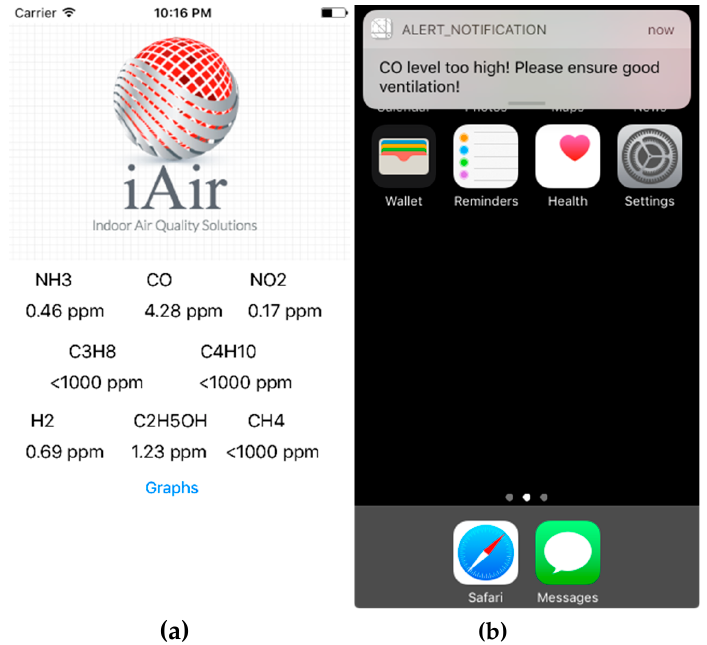
Figure 8. ( a ) iAirMobile last collected data; ( b ) example of an iAirMobile notification. Table 4. IAQ mobile applications available on